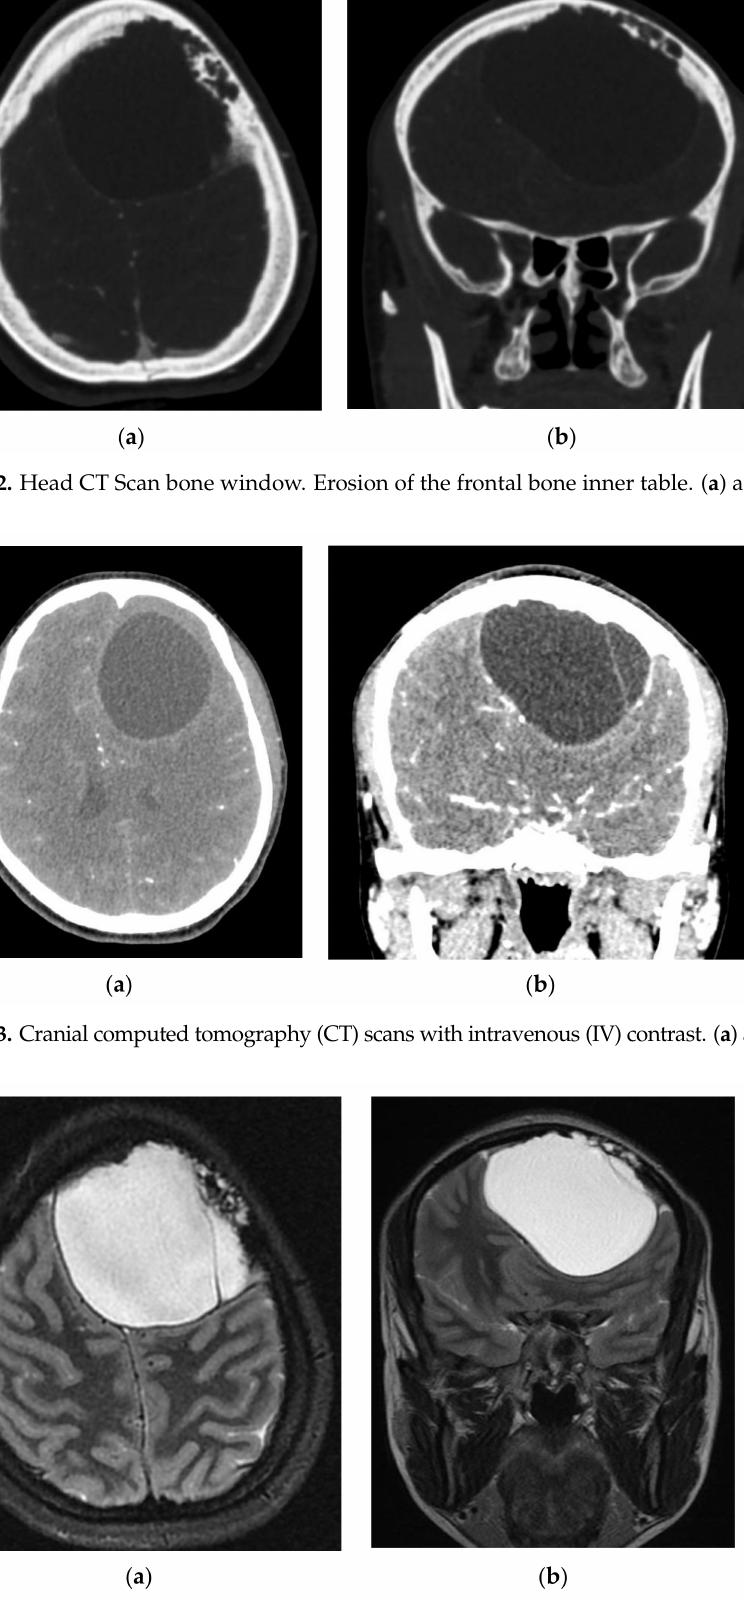
Figure 4. Cerebral magnetic resonance imaging (MRI) supports the diagnostic suspicion of intracere- bral hydatid cyst: ( a ) axial; ( b )